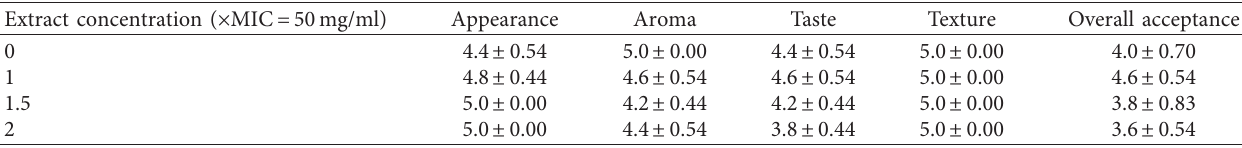
Figure 4: Radical scavenging activity of pomegranate peel extracts. Different small letters on the bars indicate significant differences ( p < 0 . 05 ) between two extracts. Different capital letters on the bars indicate significant differences ( p < 0 . 05 ) between two Table 5: Sensory evaluation of the emergency food products coated with different concentrations of ethanolic pomegranate peel extract incorporation.